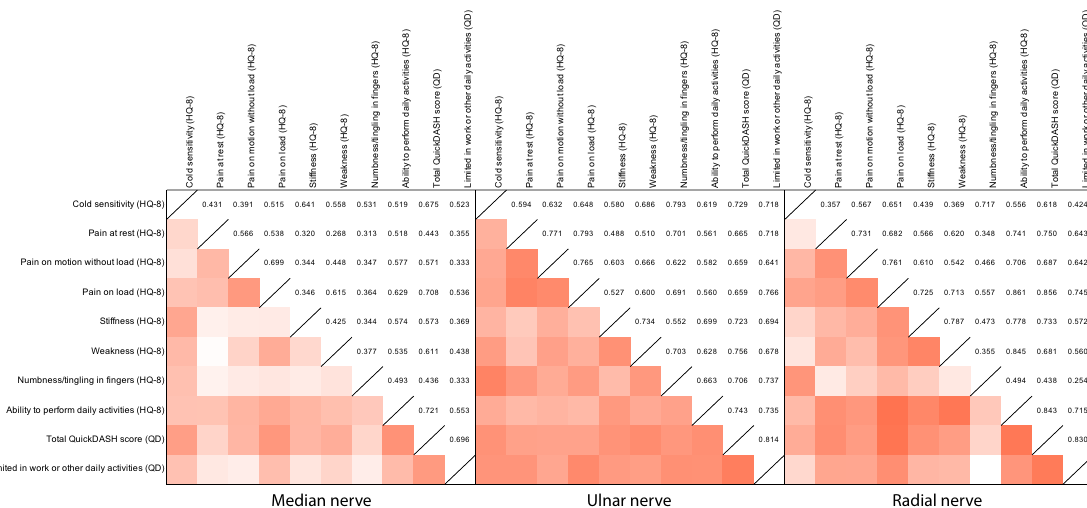
Fig 3. Correlation between cold sensitivity and other HQ-8 symptoms for a median, ulnar and radial nerve injury. Data are rho-values (Spearman rank test). Rho-values < 0.3: Weak correlation, Rho-values 0.3–0.7: Moderate correlation and > 0.7: Strong correlation. All p- values <